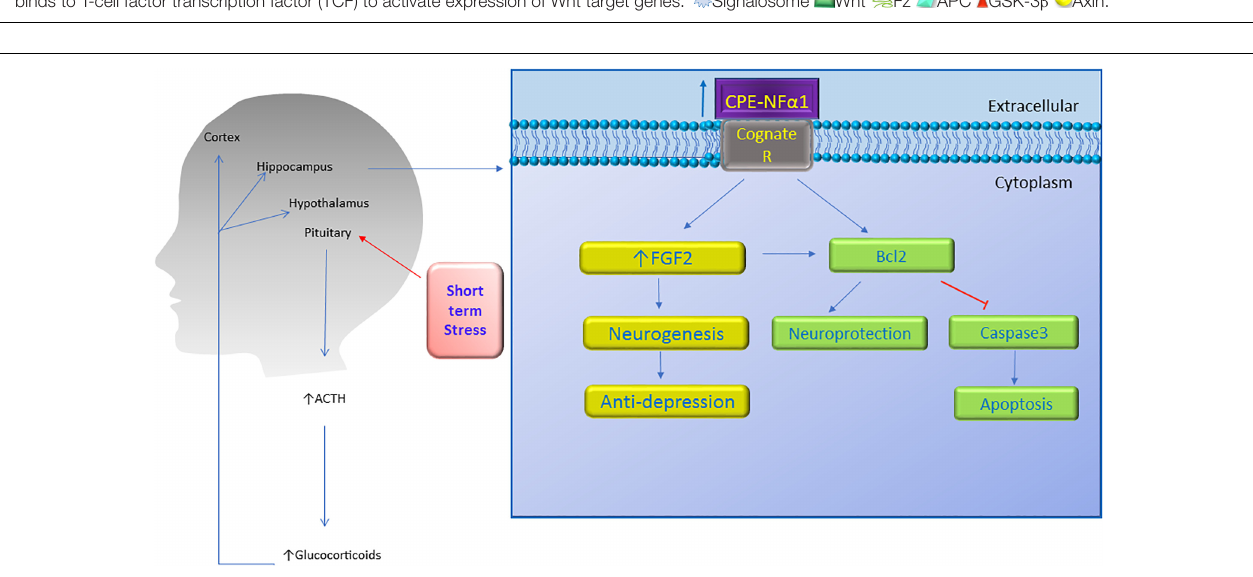
FIGURE 3 | The multiple functions of CPE-NF α 1 in the central nervous system (CNS). CPE-NF α 1 plays multiple functions in the CNS independent of its enzymatic activity. Short term restraint or weaning stress increases CPE-NF α 1 which binds to a cognate receptor and upregulates ERK1/2 and Bcl2, and decreases Bax and cytochrome c-induced activation of caspase 3 and apoptosis. CPE-NF α 1 also increases FGF2 that activates AKT and Bcl2 signaling and increases hippocampal neurogenesis and produces antidepressive-like effect. CPE-NF α 1 can also bind to Frizzled receptor – Wnt3a complex, enters the endosome that contains Wnt signaling factors and subsequently impairs the formation of signalosome. This results in β -catenin being degraded, rather than translocation into the nucleus and binds to T-cell factor transcription factor (TCF) to activate expression of Wnt target genes. Signalosome APC GSK-3 β Axin.